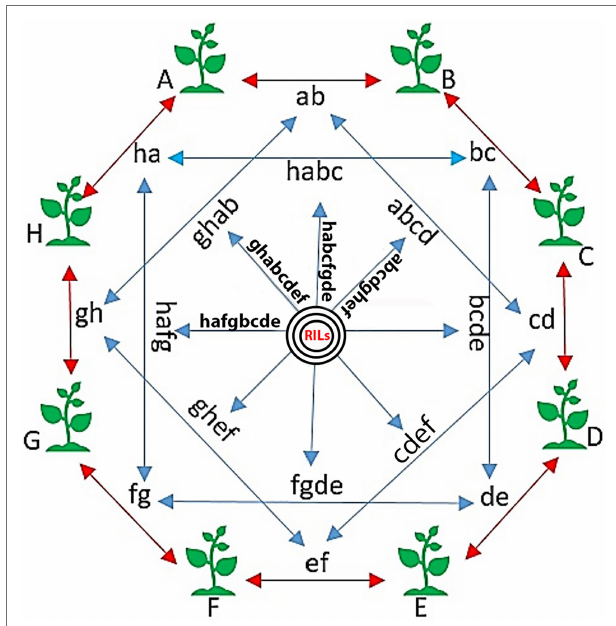
FIGURE 1 | The conical cross used to establish the SoyMAGIC population. Capital words are representing eight elite parental cultivars, (A) OAC Prosper, (B) OAC 13-55C-HL, (C) OAC 07-78C-LL, (D) AC X790P, (E) RG 46, (F) RG 22, (G) RG 11, and (H) RG 23. Two-way crosses are represented by lower case letters (ab, bc, cd, de, ef, fg, gh, and ha). Four-way crosses are represented by four lowercase letters (abcd, bcde, bcde, fgde, ghef, hafg, ghab, and habc). Eight-way crosses are represented by eight lowercase letters (bcdeghab, fgdehabc, ghefabcd, hafgbcde, etc.). Black circles are showing the selfing generations, which ends up to the final RILs.